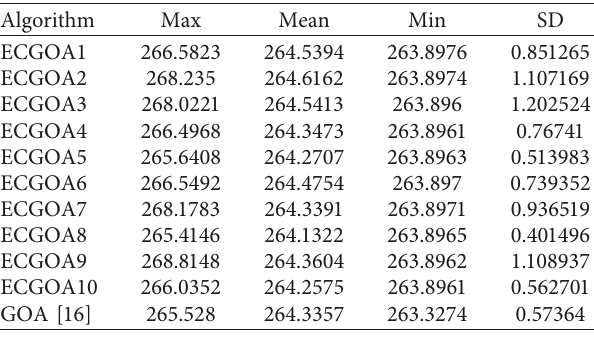
Table 9: Results of three truss bar design problem.